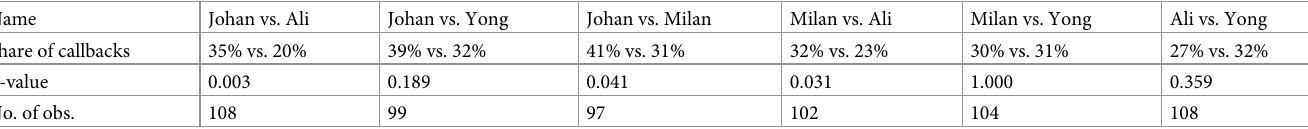
Table 4. Callback rates for each applicant pair. P-values from the Wilcoxon matched-pairs signed-rank test.